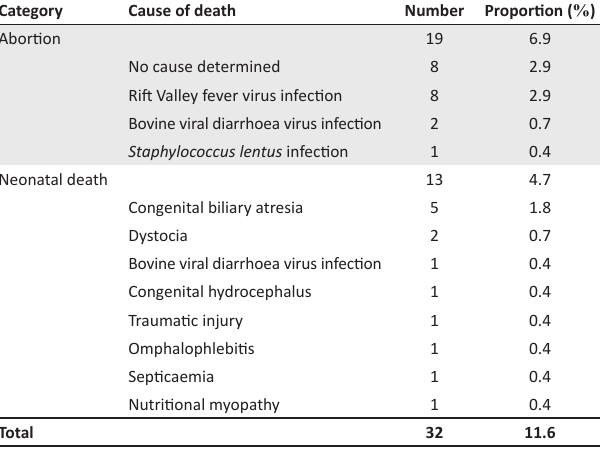
TABLE 1: Cause of death in 275 African buffaloes: Abortion and neonatal death. Category